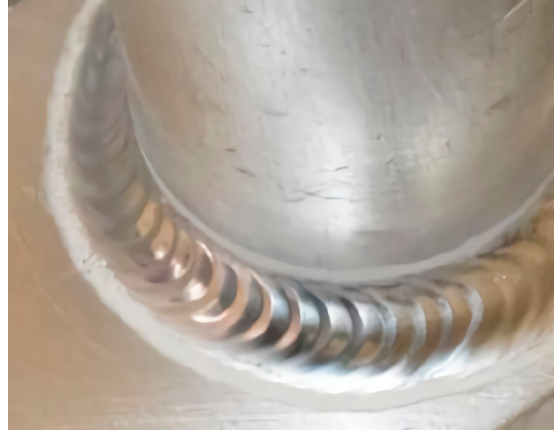
Figure 1. Arc-welded joint.